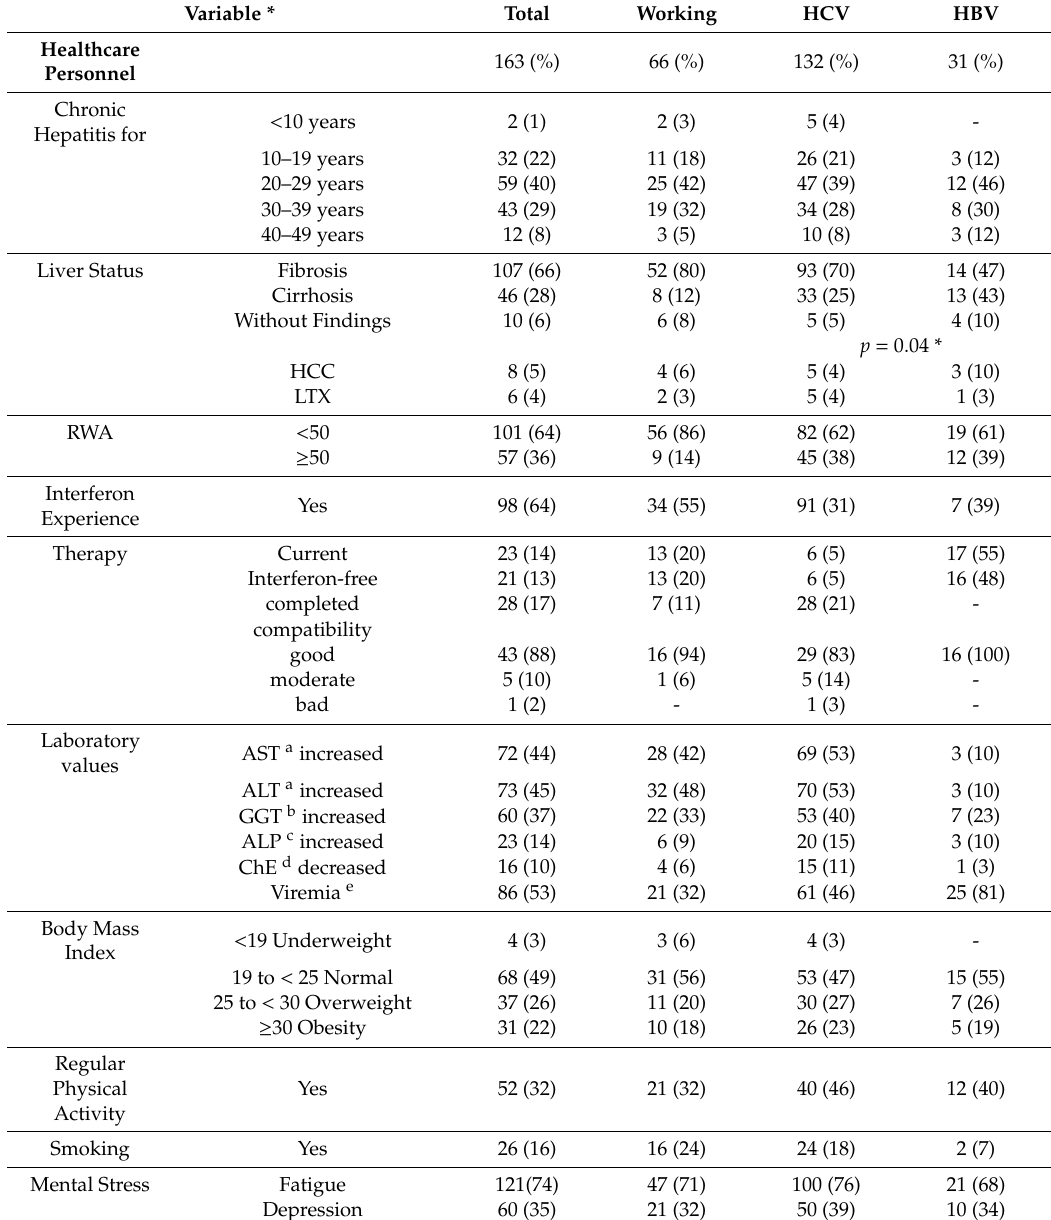
Table 2. Clinical parameters stratified by type of